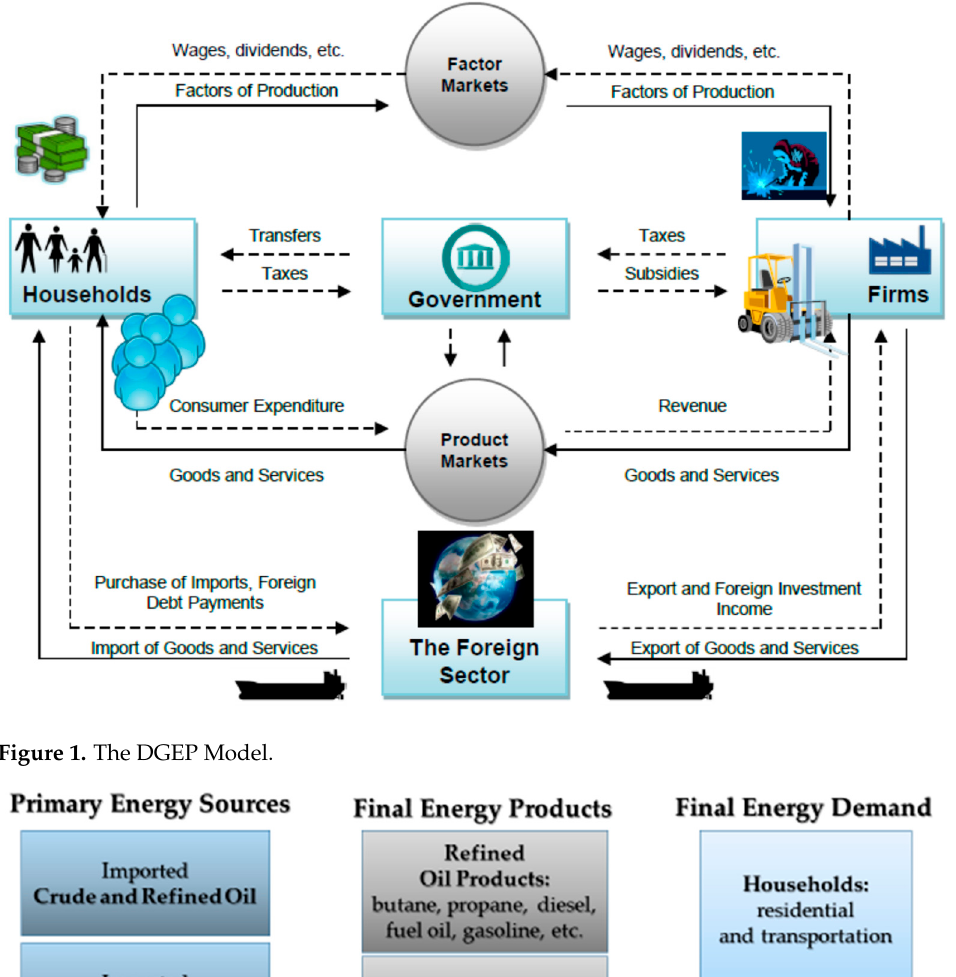
Figure 1. The DGEP Model.